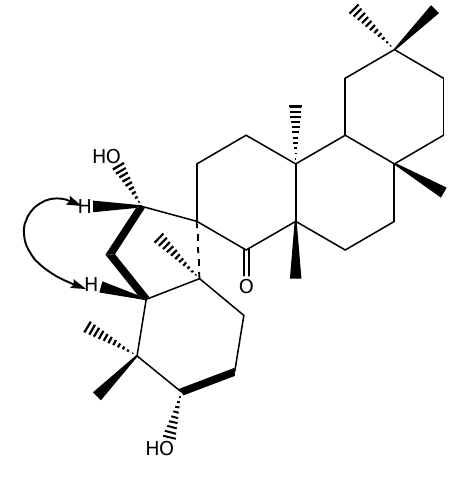
Figure 3. Important COSY ( ▬ ) and NOESY ( ↔ )